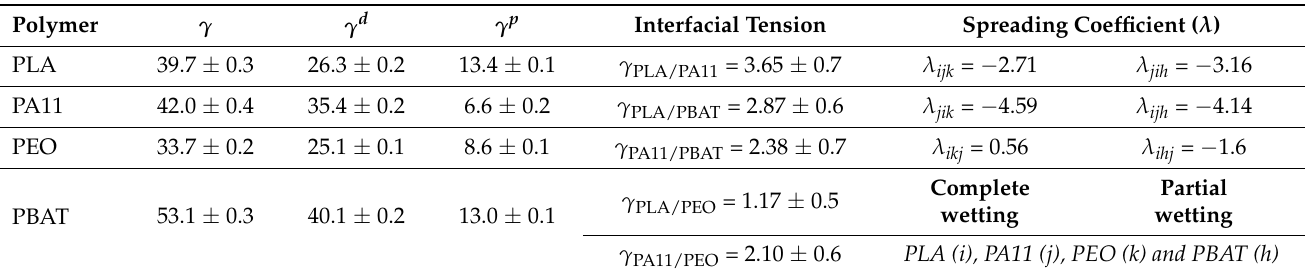
Table 1, a negative spreading coefficient ( λ PLA/PBAT/PA11 = − 1.6 mN/m) predicts a